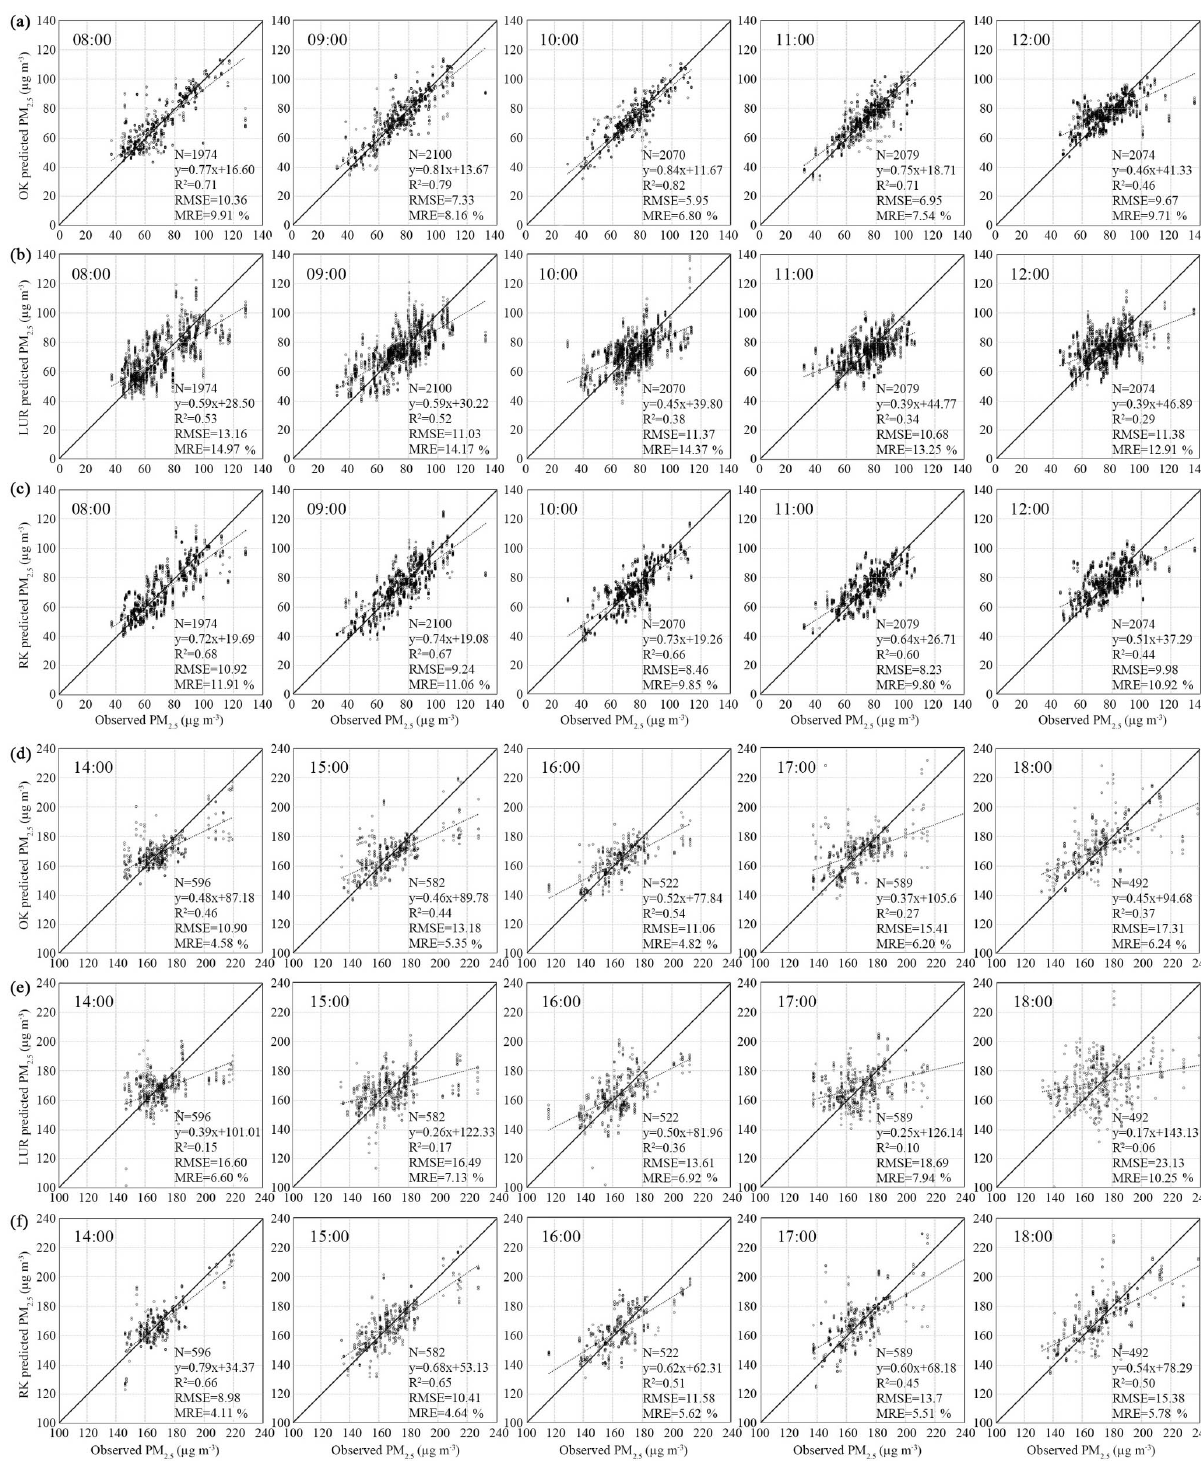
Figure 5. Scatter plots of repeated validating results with 90% training sites for (a) OK, Period 1; (b) LUR, Period 1; (c) RK, Period 1; (d) OK, Period 2; (e) LUR, Period 2; and (f) RK, Period 2. The solid line is the 1 : 1 line, which is a